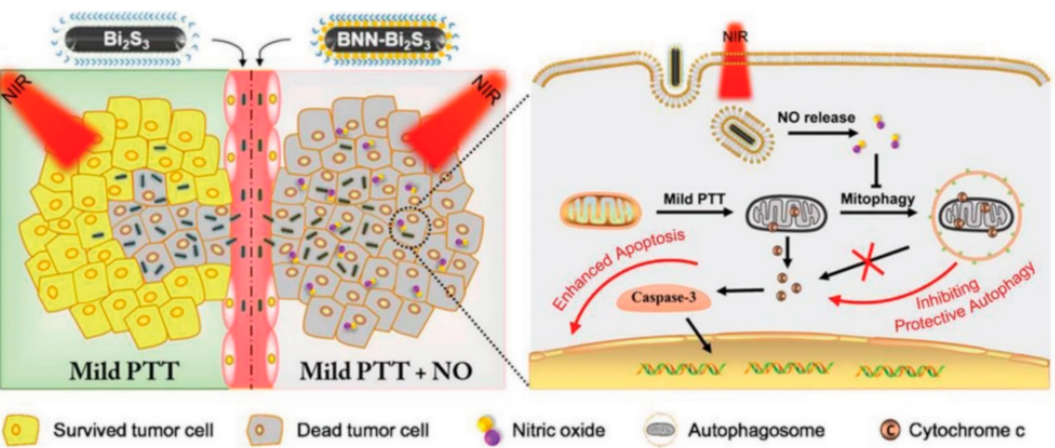
Figure 5. Autophagy is a prosurvival pathway in mild PTT, which can demolish the damaged mitochondria, reduce the release of cytochrome c, and inhibit the activity of caspase-3. NO downreg- ulates the autophagy level to decrease its effects and triggers cellular apoptosis. Reproduced with permission from